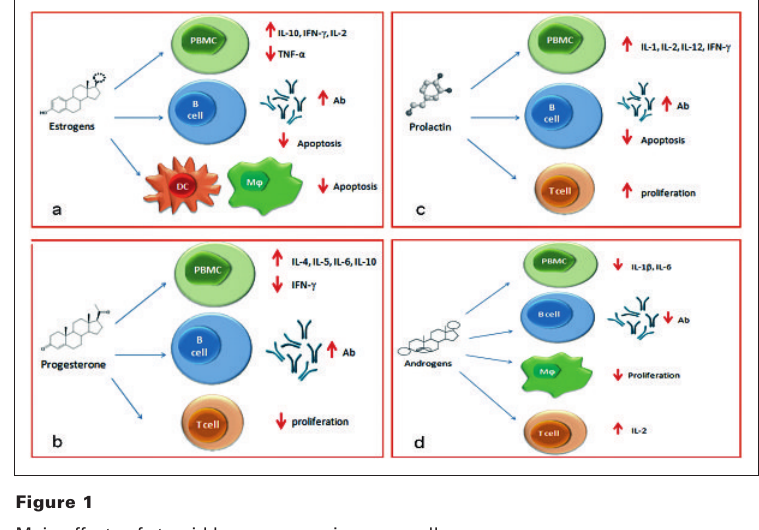
Main effects of steroid hormones on immune cells. a Oestrogens enhance interleukin (IL)10, IL-2, and interferon gamma (IFN- g ) produc- tion, and inhibitTNF- a secretion by peripheral blood mononuclear cells (PBMC); stimulate antibody (Ab) production by B cells, and decrease apoptosis of dendritic cells (DC) and macrophages (M j ). b Progesterone enhances IL-4, IL-5, IL-6, and IL-10 production, and inhibits IFN- g production by PBMC; stimulates Ab secretion by B cells, and decreasesT cell proliferation. c Prolactin enhances IL-1, IL-2, IL-12, and IFN- g secretion by PBMC; stimulates Ab secretion, decreases B cell apoptosis, andT cell proliferation. d Androgens inhibit Il-1 b and IL-6 secretion by PBMC and enhance IL-2 secretion by T cells; inhibit Ab secretion by B cells and M j